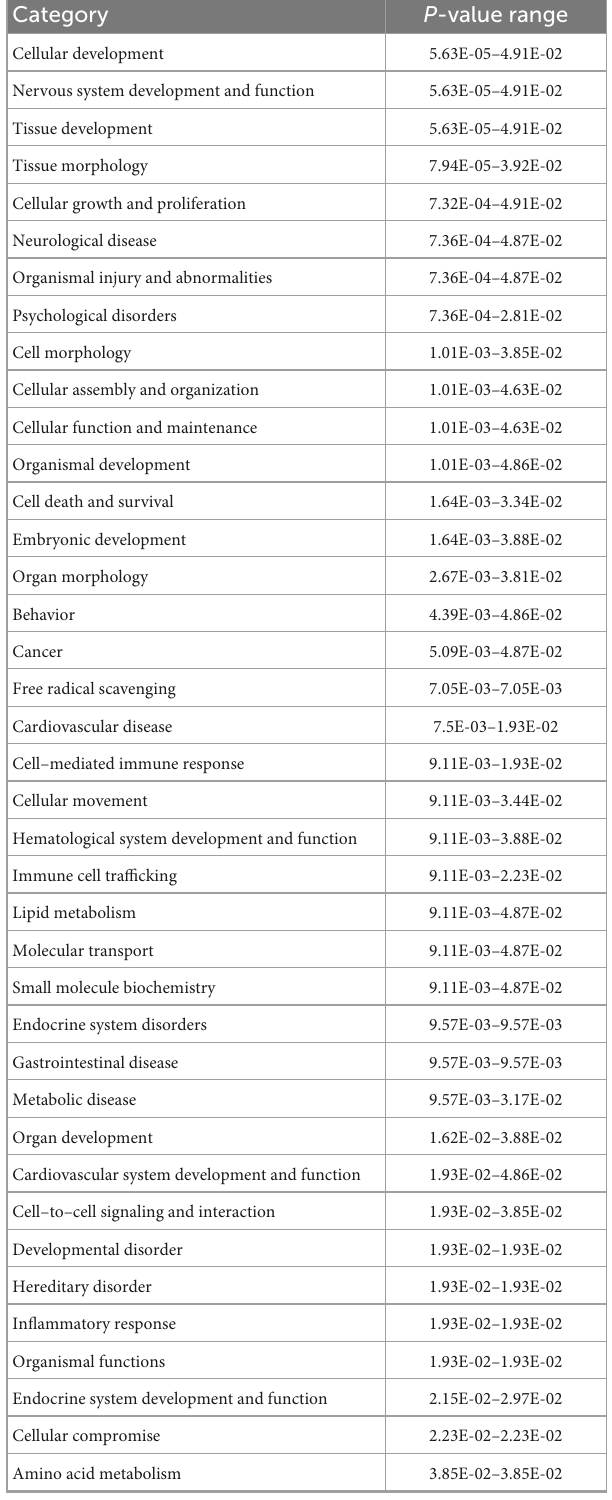
TABLE 2 P6-Top diseases and biological functions altered by ethanol